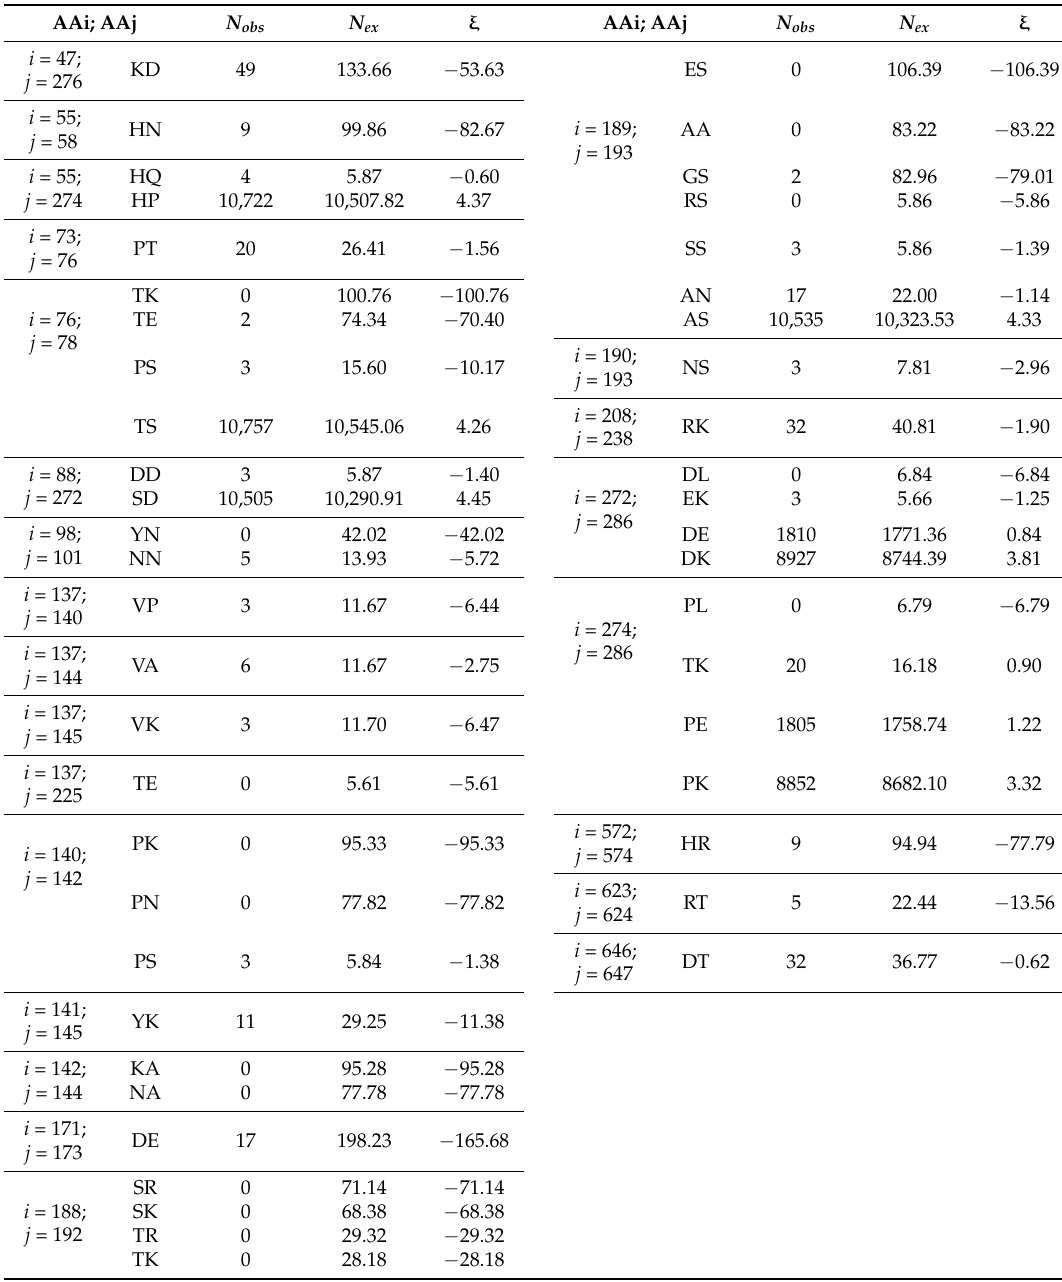
Table 1. H1N1 hemagglutinin (HA) pairs of synthetic lethals (SL) and compensatory mutations (CM). AAi;